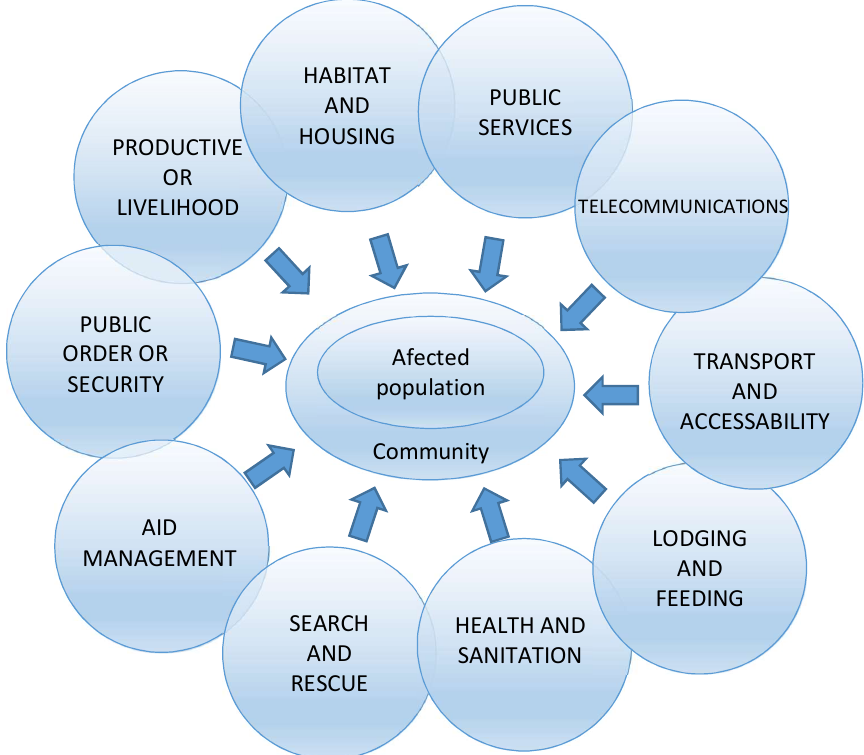
Fig. 4. Colombian post-disaster humanitarian system. Source: Based on Moreno,